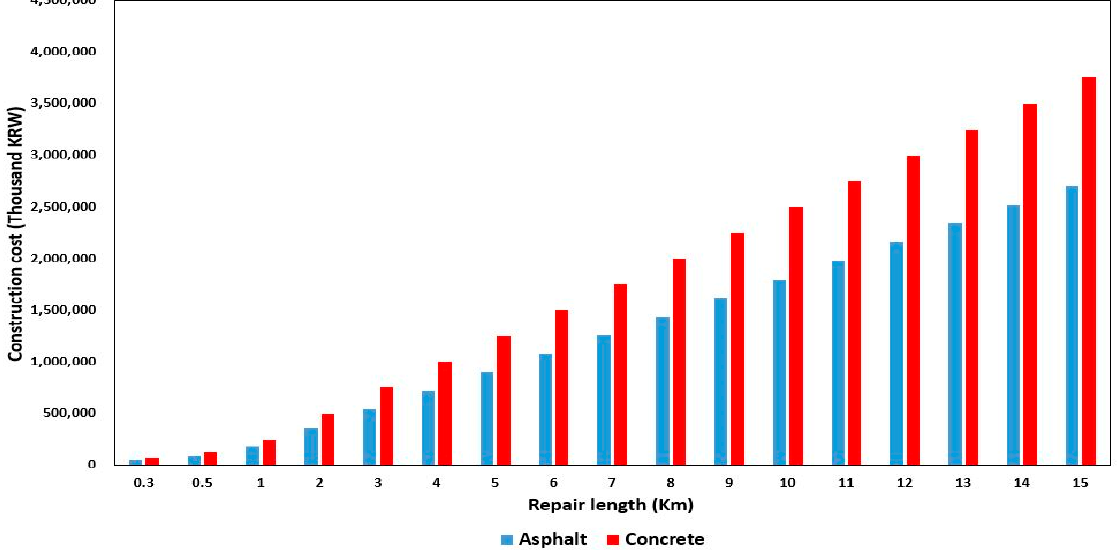
Figure 5. The construction cost by repair length.